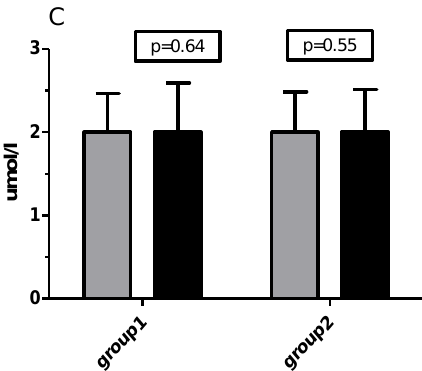
Figure 5. Changes in TOS / TOC ( A ), TAS / TAC ( B ), and prooxidative / antioxidative ratio ( C ) before (grey bars) and after 6 weeks of the unsupplemented training period (dark bars).